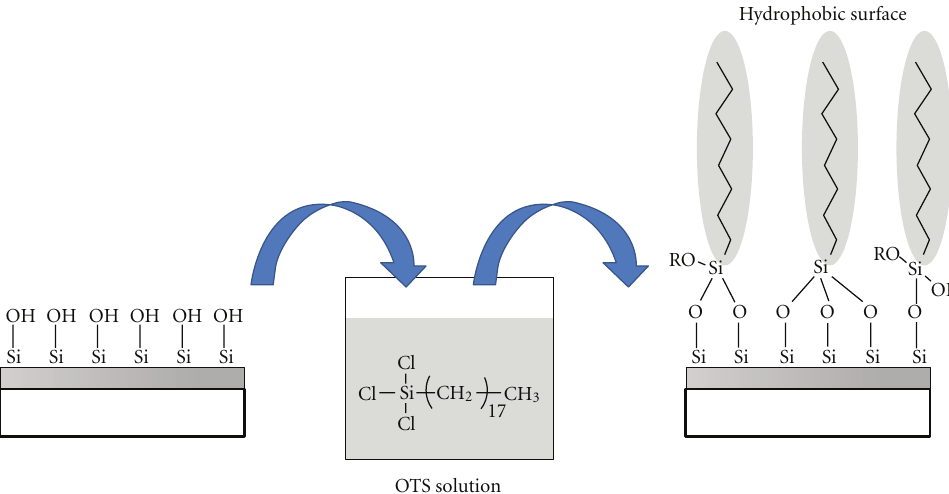
Figure 9: Surface modification of PMSQ film with alkyltrichlorosilane.